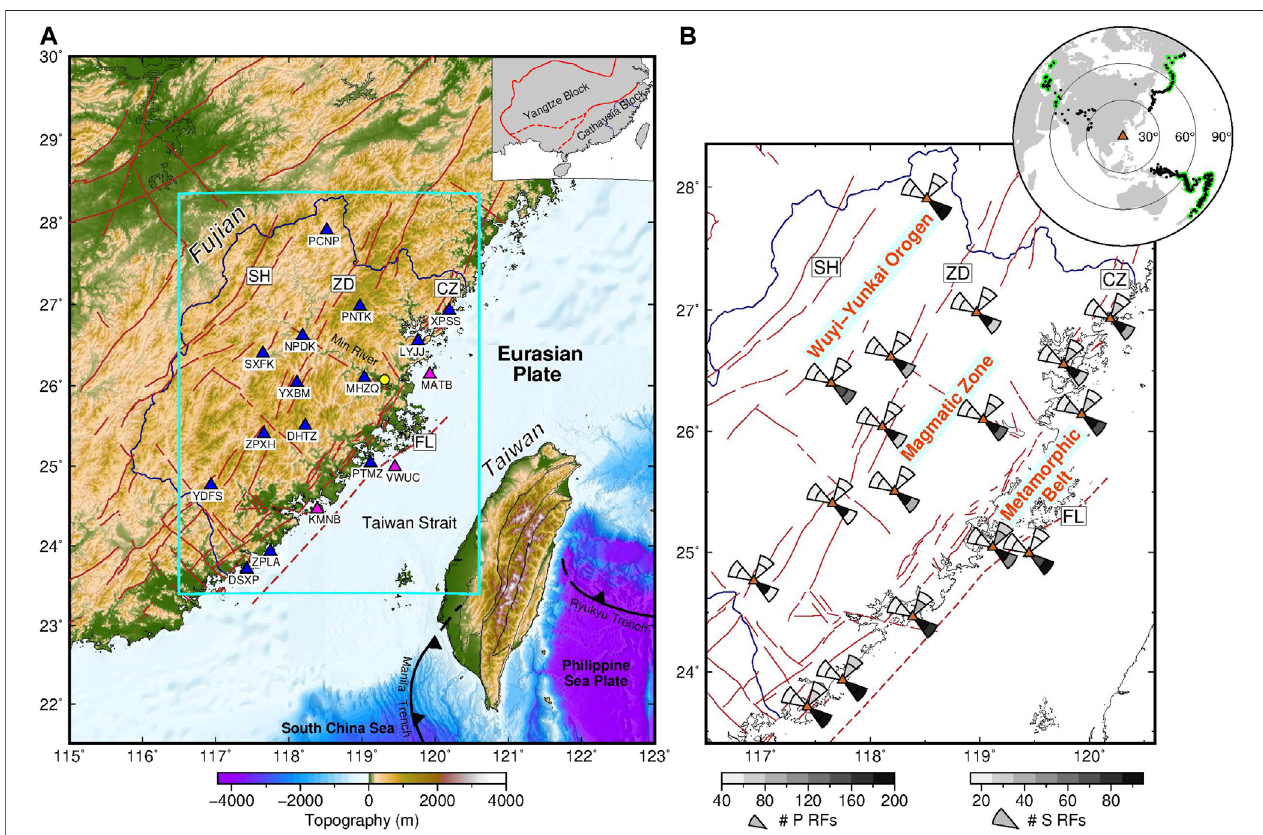
FIGURE1|(A) TopographicmapofSEChinashowingthelocalityoftheFujianprovinceinthenortheastCathaysiaBlockandthedistributionofstationsusedinthe study.TheupperrightinsetmapdisplaystheYangtzeandCathaysiaBlocksamalgamatedtoformtheSouthChinaCraton.The14FEAandthreeBATSstations,located within our study region bounded by the cyan box, are denoted by blue and magenta triangles, respectively. Red lines delineate the faults mapped in the land (solid) and offshoreareas(dashed)(Dingetal.,1999),whileblacklinesdrawtheborderoftheFujianprovince.AsolidyellowdotneartheMinRivermarksthelocationofFuzhou basin. The NE-SW trending suture zones in the Fujian region are abbreviated: SH, Shaowu-Heyuan fault zone; ZD, Zhenghe-Dapu fault zone; CZ, Changle-Zhaoan fault zone;FL,theFujianlittoralfault. (B) ThenumbersofPandSRFsfromindividualbackazimuthsectors(NW,NE,andSE)usedforH-Vstacking.Gray-coloredsectorswith smaller and larger radii indicate the respective numbers of P and S RFs in the three backazimuth ranges. The upper right inset map shows the epicentral distance and azimuthal distribution of teleseismic events providing usable P (solid black circle) and S (green open circle) RFs.